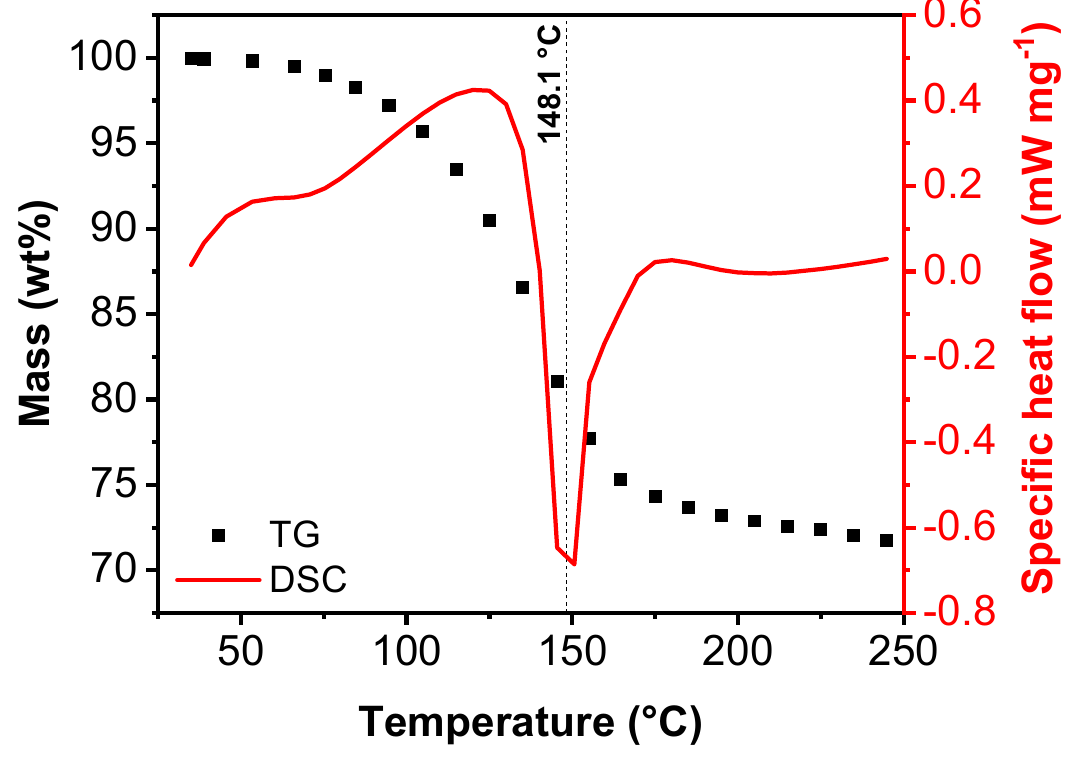
Figure 2. Thermogravimetric curve (black) and differential-scanning-calorimetry curve (red) of the synthesized CuHCF powder.